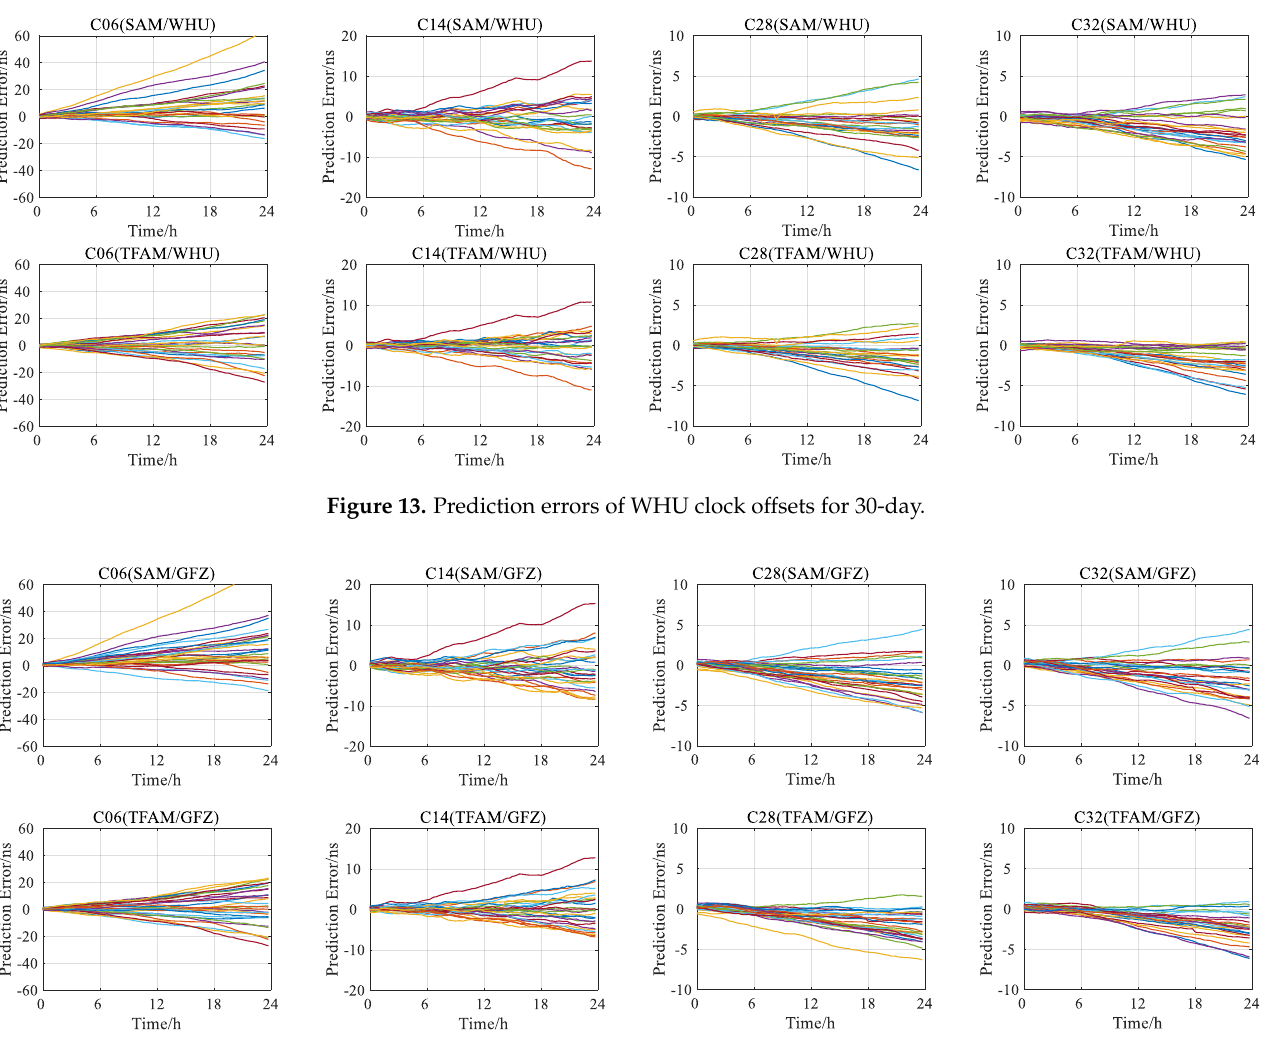
Figure 14. Prediction errors of GFZ clock offsets.